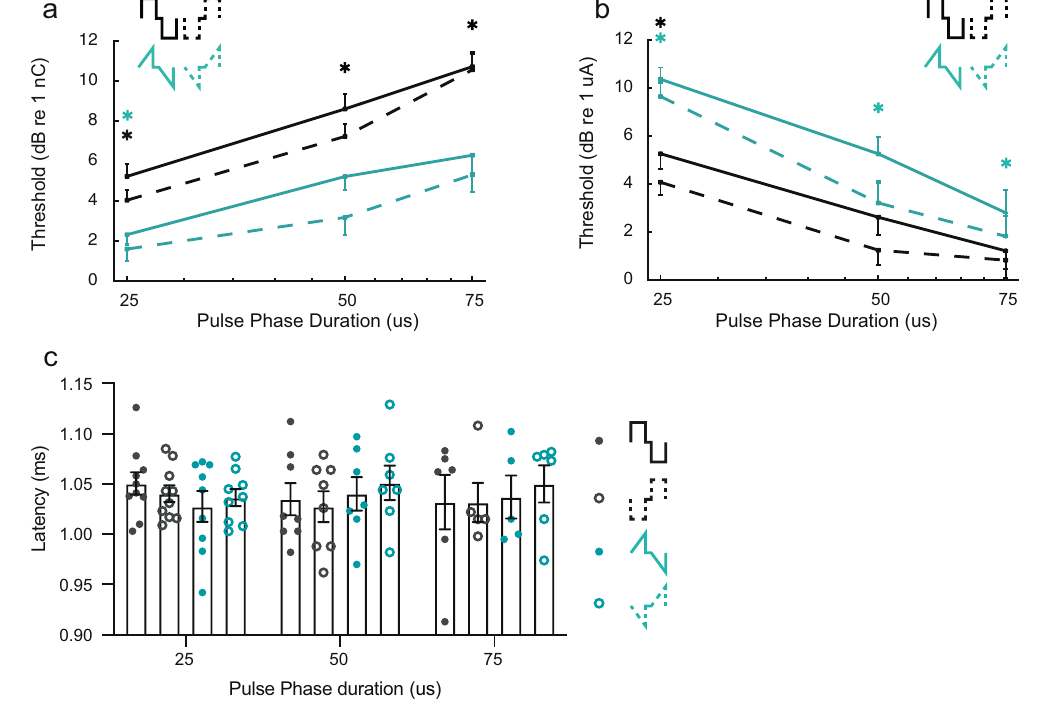
Figure 4. RampUP is more charge-efficient than Rec at longer phase durations. Thresholds of increasing phase durations (25 µ s, 50 µ s, 75 µ s) with Rec (black) and rampUP (green) in terms of ( a ) amplitude current level and ( b ) charge injected. Solid line, anodic-first pulses; dashed, cathodic-first pulses. n = 12 mice for 25 µ s/phase and 50 µ s/phase, n = 9 mice for 75 µ s/phase. Black and green asterisks denote significant effect in post hoc test of the pulse shape * polarity interaction (Tukey HSD) of Rec and rampUP, respectively. * p ≤ 0.05. Only one error bar is shown for simplicity. ( c ) Latency of wave II at three dB (re 1 nC) above threshold for ramp Rec (black) and rampUP (green). Each circle is data from one mouse. M7 and M9 are excluded. Closed circles, anodic-first pulses; open circles, cathodic-first pulses. n = 10 mice for 25 µ s/phase, n = 7–8 mice for 50 µ s/phase, n = 5–6 mice for 75 µ